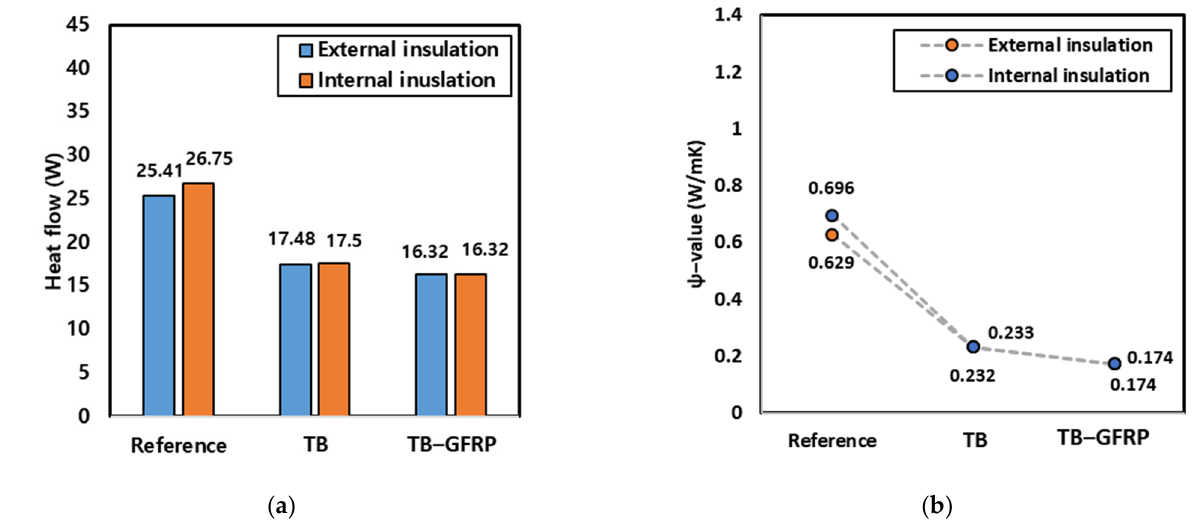
Figure 5. Simulation results under air heating condition: ( a ) Heat flow through the balcony–slab thermal bridge; ( b ) ψ -value.